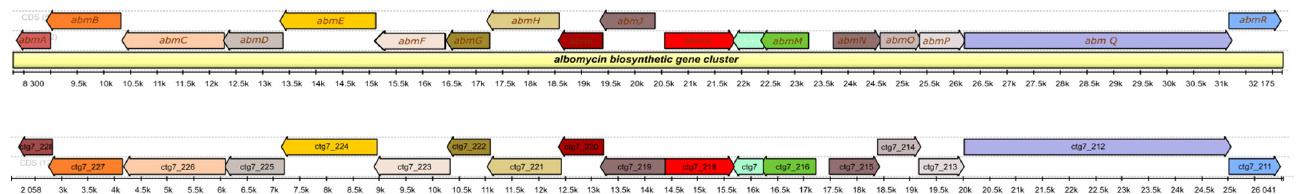
Figure 3. Biosynthetic gene clusters of albomycins: genetic organization of the albomycin (abm) gene cluster in Streptomyces sp. ATCC 700974 ( top ) and gene cluster in Streptomyces globisporus subsp. globisporus 4-3 ( bottom ). The homologous abm and ctg genes are filled with the same colors.